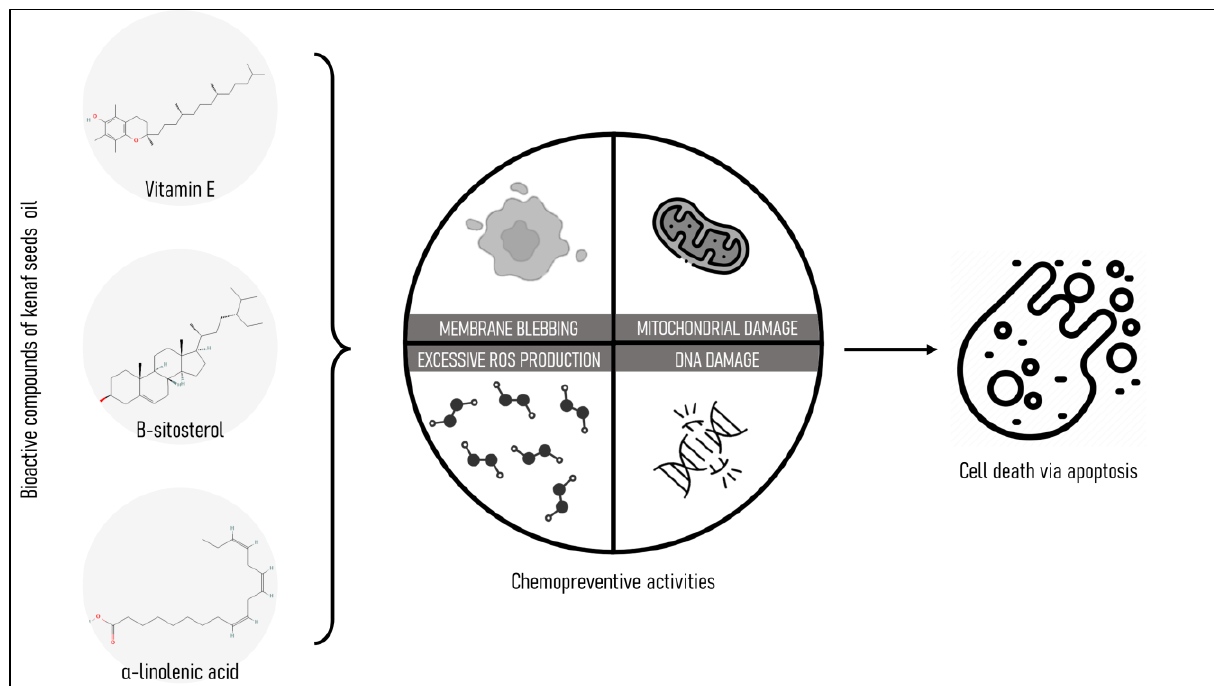
Figure 5. Graphical illustration of kenaf seed oil mechanism in combating cancer cells.